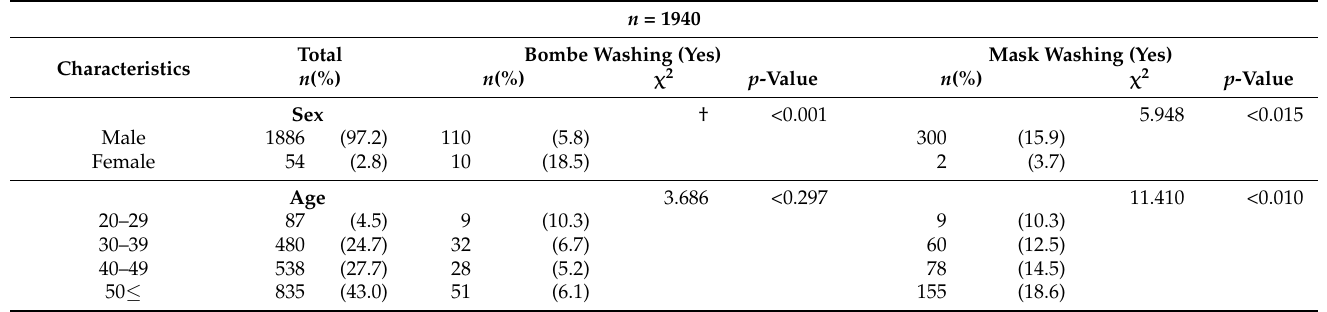
Table 1. Associations between general characteristics and decontamination